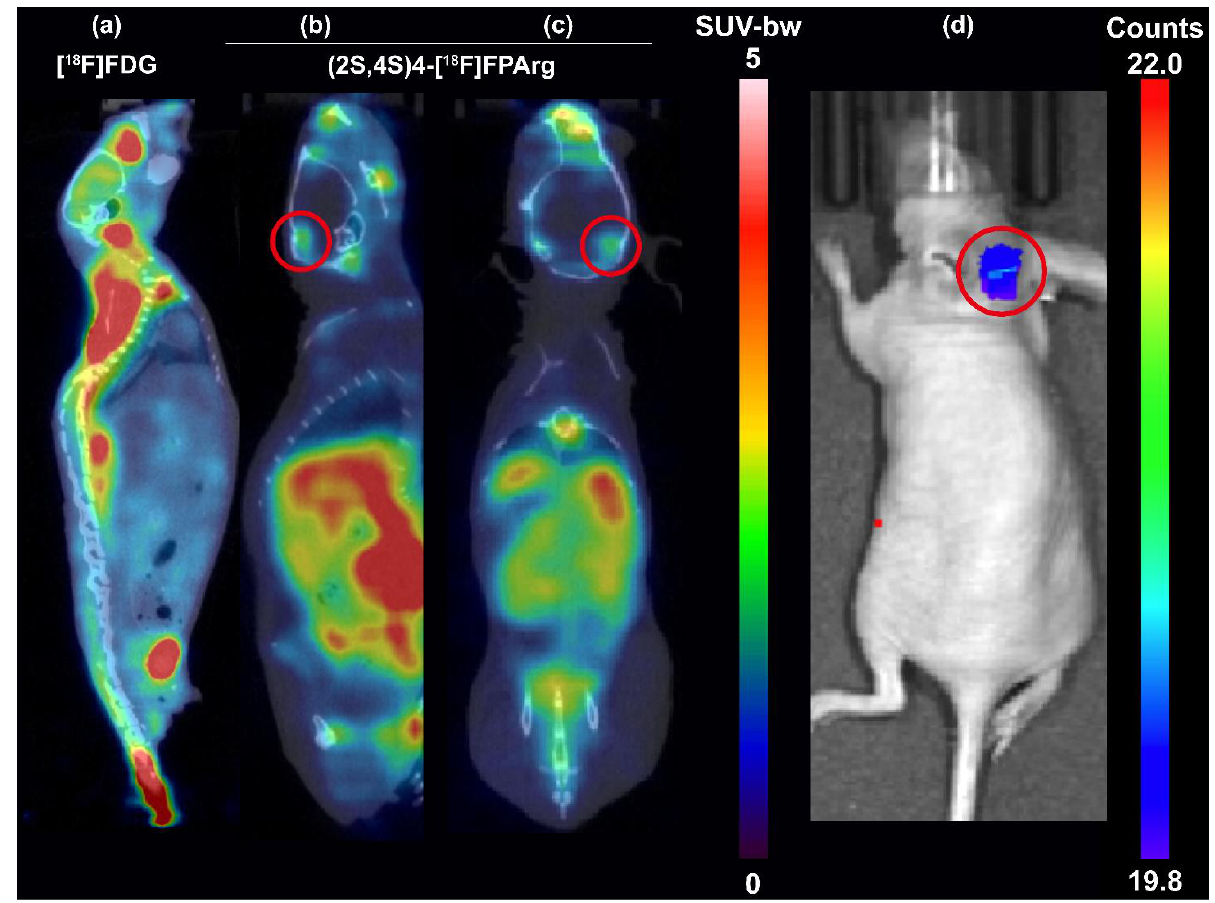
Figure 4. ( a ) The microPET – CT sagittal image of [ 18 F]FDG in HS683 – Luc tumor – bearing nude mice; The microPET – CT sagittal ( b ) and coronal ( c ) images of (2S,4S)4 – [ 18 F]FPArg in HS683 – Luc tumor – bearing nude mice; ( d ) Bioluminescence imaging was collected for 1 min in a nude mouse bearing HS683 – Luc glioma after injection of D – luciferin, where the red circle indicates glioma area.